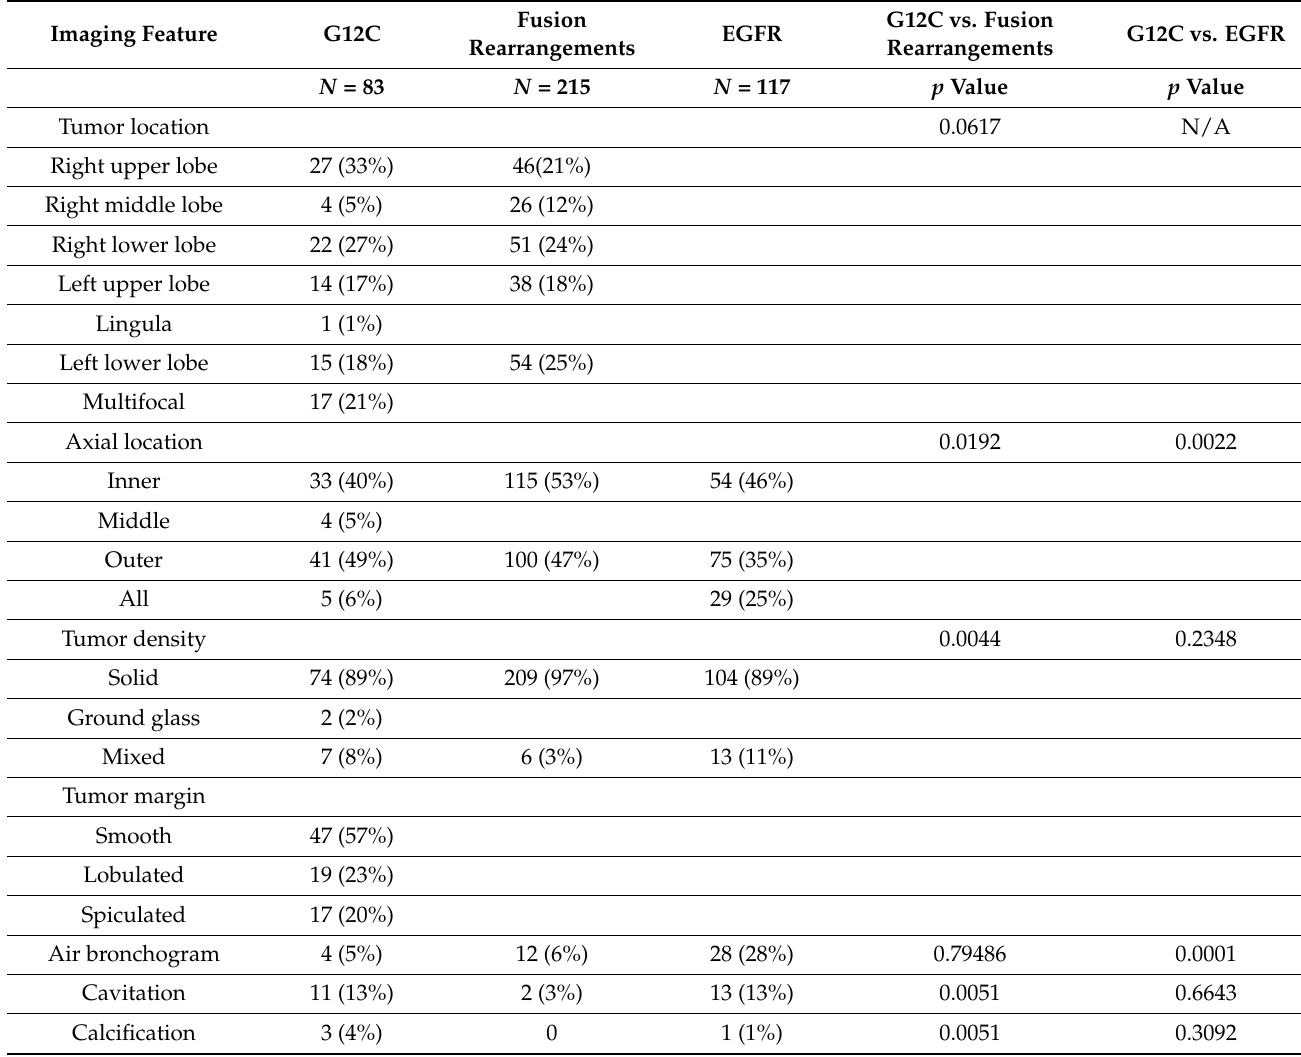
Table 5. Imaging features of the primary tumor in G12C KRAS and other targetable genetic alteration-driven NSCLC. Imaging